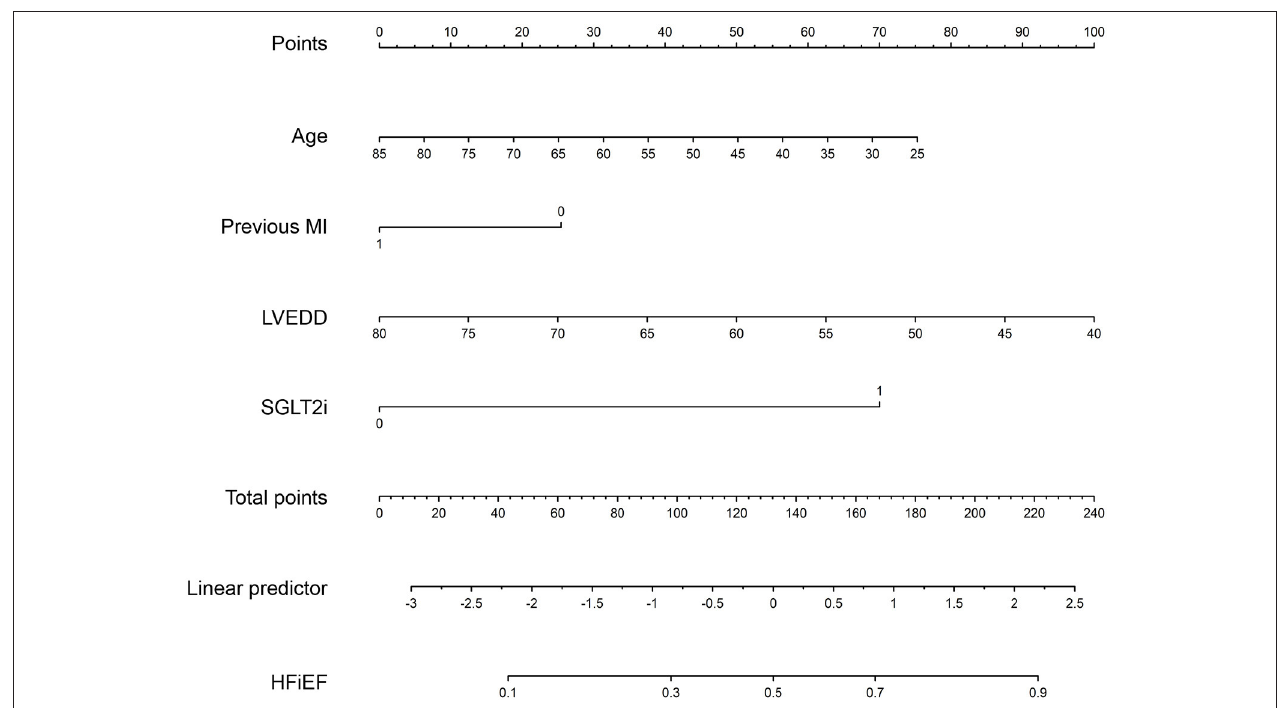
FIGURE 3 | A nomogram to predict the probability of HFiEF 1 year after successful CTO PCI in patients with heart failure. MI, myocardial infarction; LVEDD, left ventricular end-diastolic dimension; SGLT2i, sodium glucose cotransporter 2